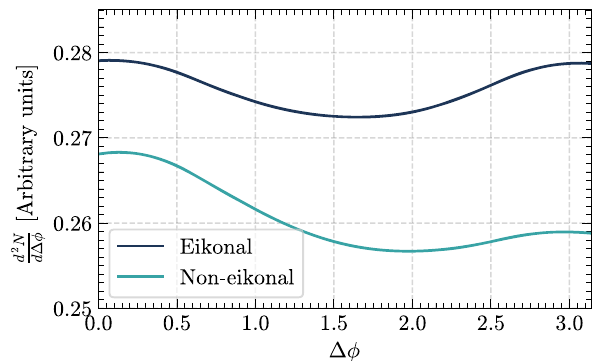
Fig. 6 The double inclusive gluon spectrum given in Eq. (5.11) and its eikonal limit as a function of the azimuthal angle (cid:11)φ . In this plot, we √ s NN = 100 GeV, η 1 = η 3 = 0 . 2 and | k 1 | = | k 3 | = 1 have fixed